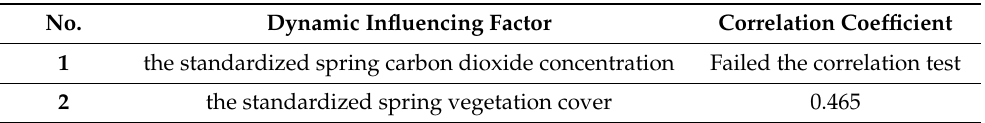
Table 3. Correlation coefficients between the standardized temperature change and dynamic influ- encing factors in spring.